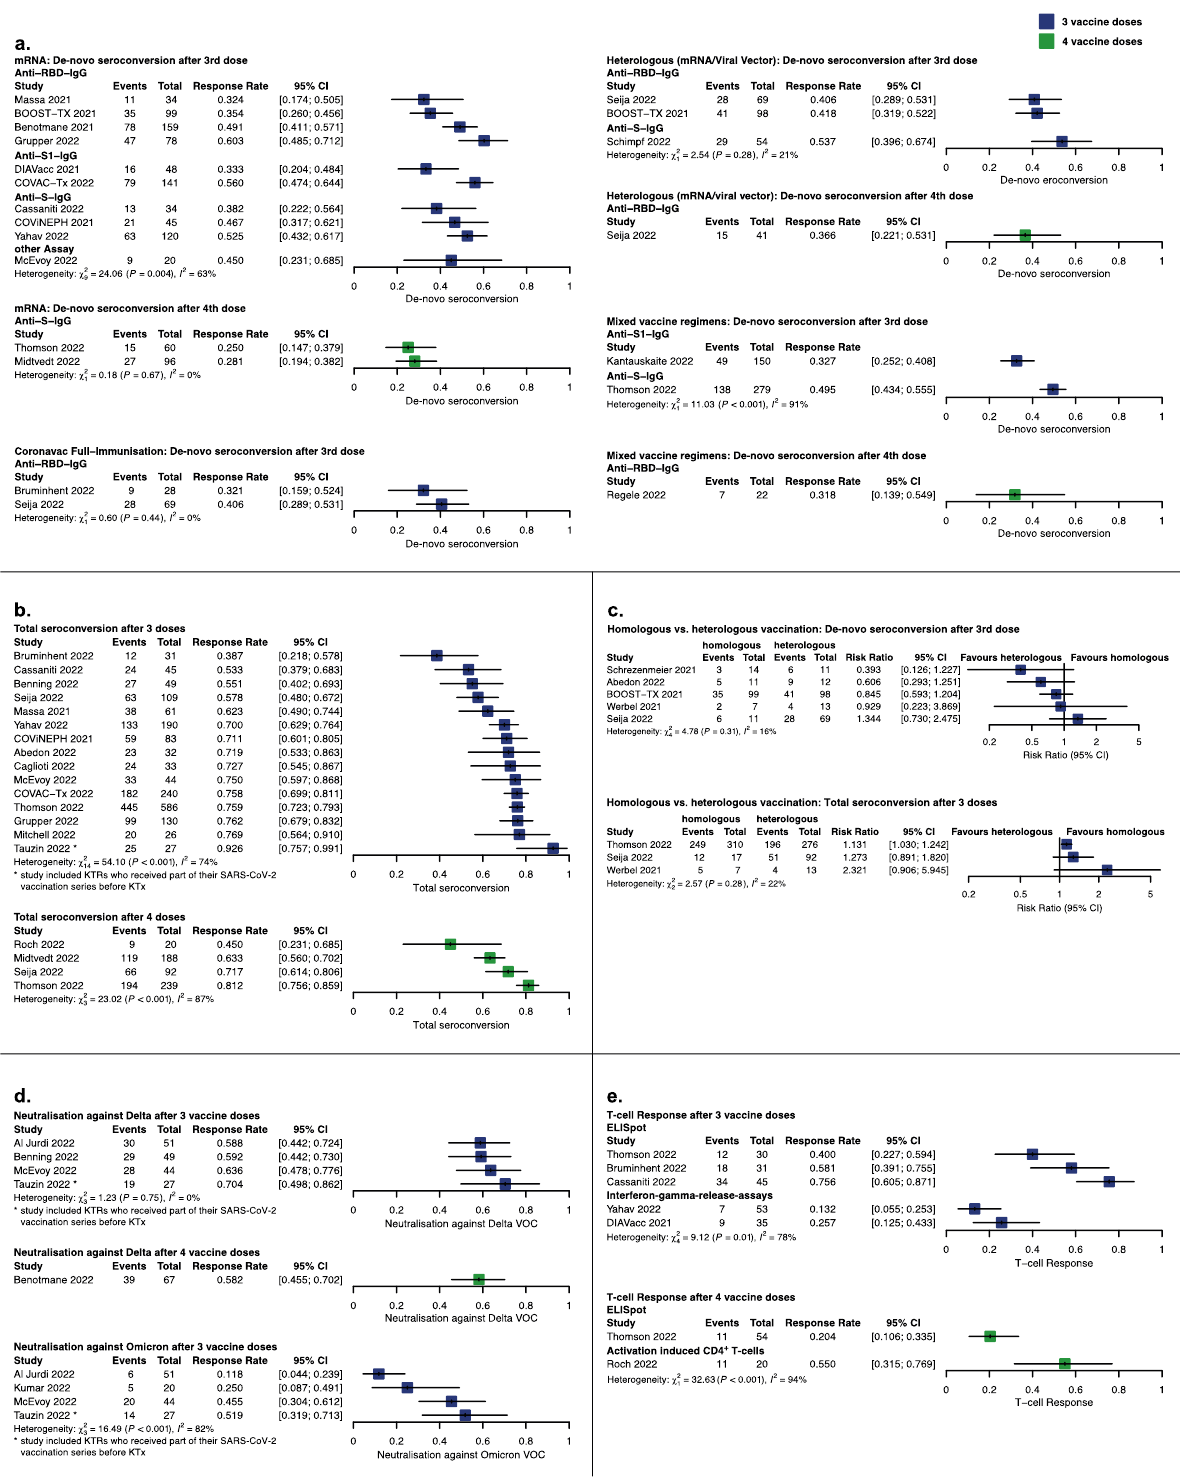
Figure 2. Seroconversion and seroresponse after SARS-CoV-2 vaccination depicted as forest plots. ( a ) De novo seroconversion after the third and fourth vaccine dose stratified according to vaccine type and assay used to define seroconversion. ( b ) Total seroconversion (KTRs seropositive after last vaccine dose including previously seroconverted KTRs) after three and four vaccine doses. ( c ) Studies comparing de novo and total seroconversion in homologous (mRNA) and heterologous (mRNA/viral vector) vaccination strategies. ( d ) Variant-specific neutralization after three and four vaccine doses. ( e ) T-cell responses strati- fied according to assay after three and four vaccine doses.